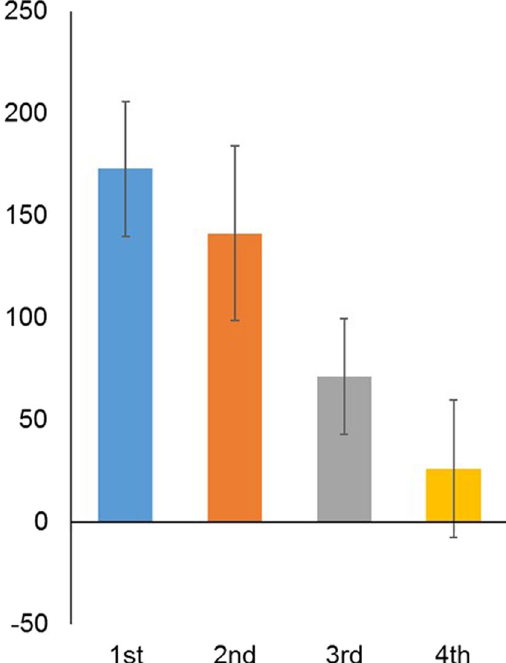
Figure 3. Mean acquiescence (Y axis) in each year (X axis). Error bars represent standard errors of the